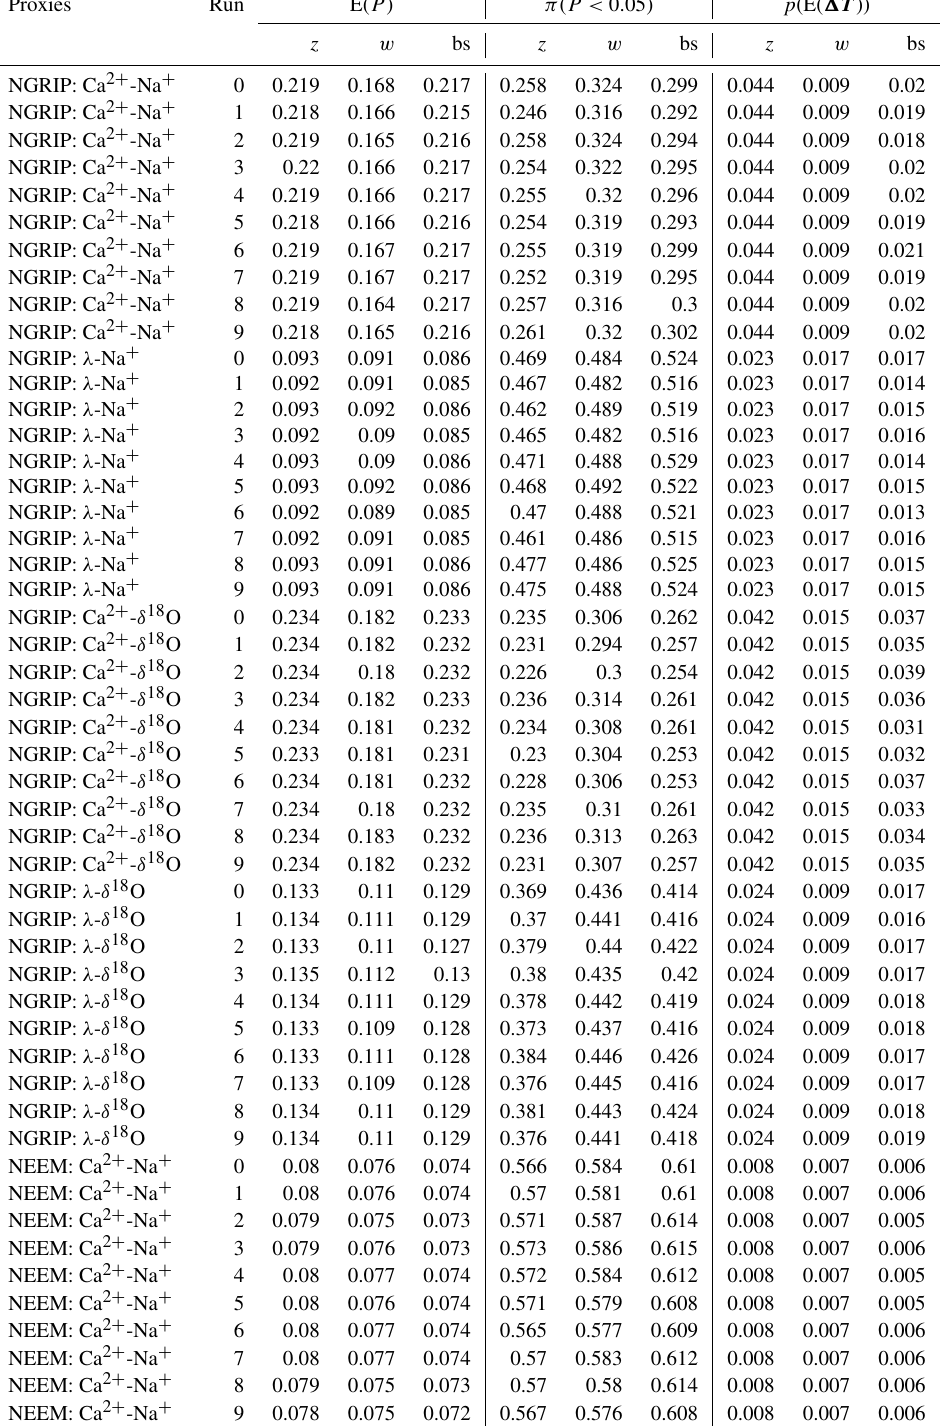
Table B1. Results obtained from the application of hypothesis tests to the control group. Reported are the mean p values E( p ( (cid:49) ˆ T )) together with the probability of the uncertain sample to yield a p value below the significance level π ( p ( (cid:49) ˆ T ) < 0 . 05) and the p values of the expected samples p (E( (cid:49) ˆ T )) for all three tests. All results were derived from the corresponding empirical densities ρ labels z , w , and bs indicate results obtained from the t test, the WSR test, and the bootstrap test. The results presented in the main text are given by the p – q –0 run for each proxy variable. The data presented here are provided in the Supplement to this